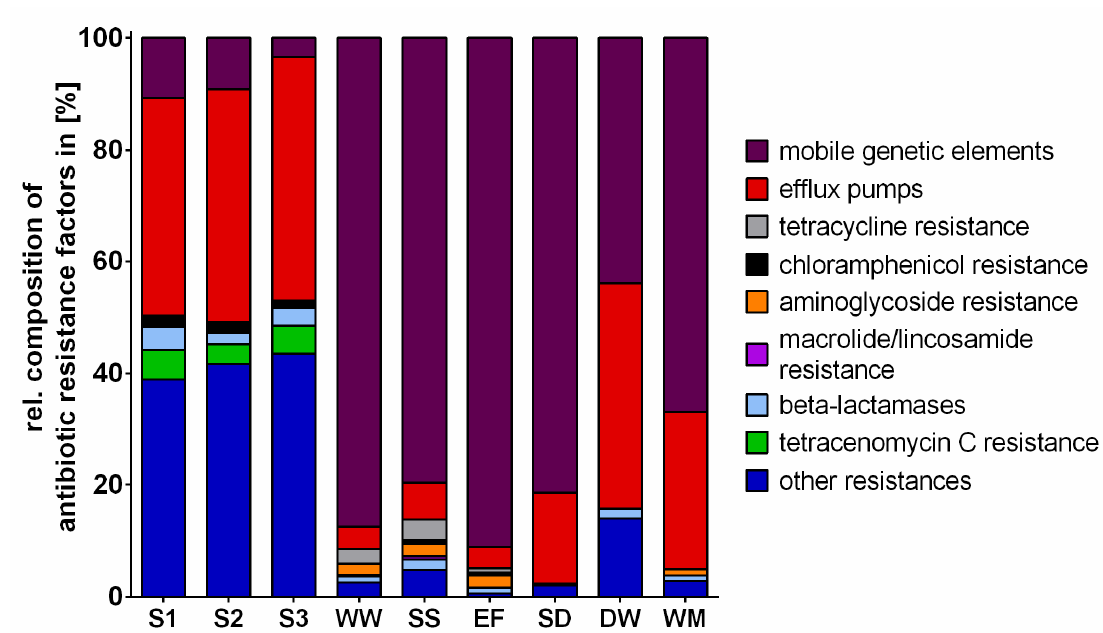
Figure 4. Relative composition of reads annotated to antibiotic resistance factors in soil samples (S1 ( n = 4), S2 ( n = 4), S3 ( n = 4)), WWTP (WW ( n = 4), SS ( n = 5), EF ( n = 4)) and HH samples (SD ( n = 1), DW ( n = 1), WM ( n = 4)). Sequence reads were mapped against the microbial virulence database (MvirDB).